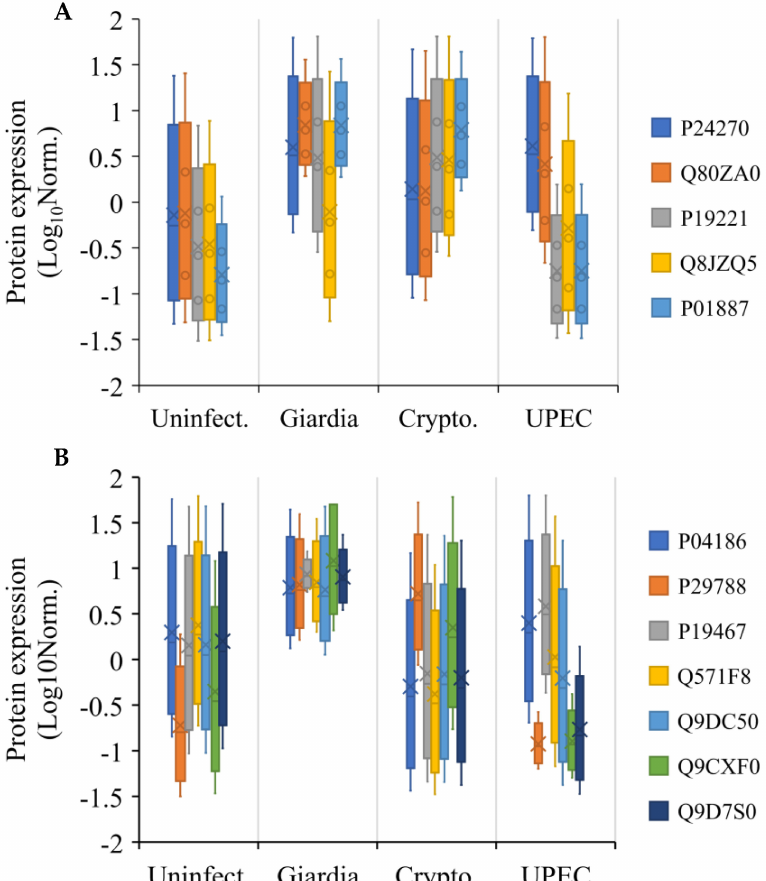
Figure 7. Log 10 normalised expression of proteins from ( A ) serum and ( B ) liver which were observed to be involved in cellular protection as an extra-intestinal effect of various gut infections in the mouse model. Note: The protein identifiers refer to the Uniprot